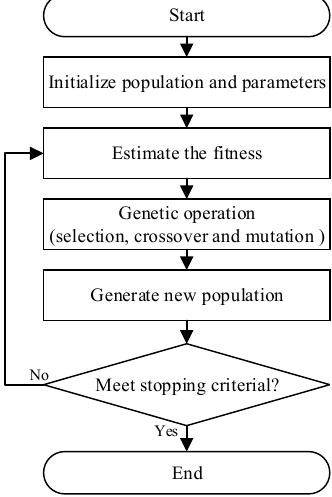
Figure 4. Flowchart of the optimization procedure of GA.